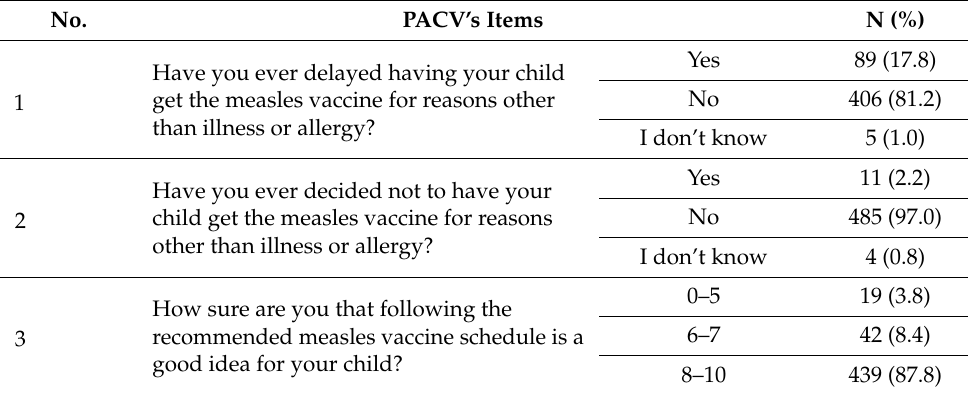
Table 2. Frequency distribution of the 15 PACV items (N =